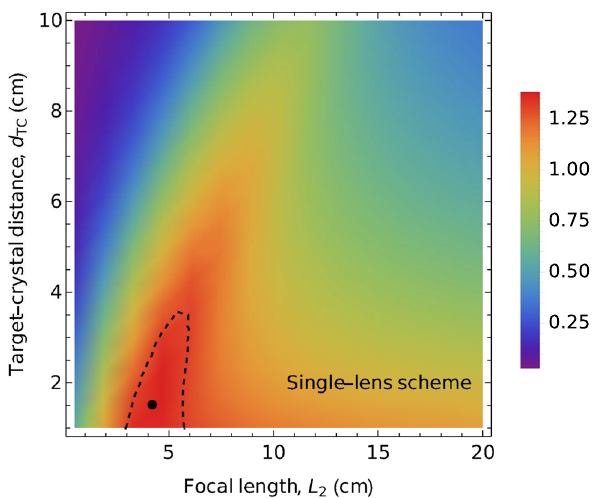
Fig. 9 Efficiency gain of the single-lens scheme as a function of the target-crystal distance and the focal length. Besides the geometrical trapping condition, also the exponential decay of the (cid:2) + c particles for variations of the the target-crystal distance is accounted for. The coun- tour line encloses the region with a 5% variation with respect to the optimal point, shown as a black